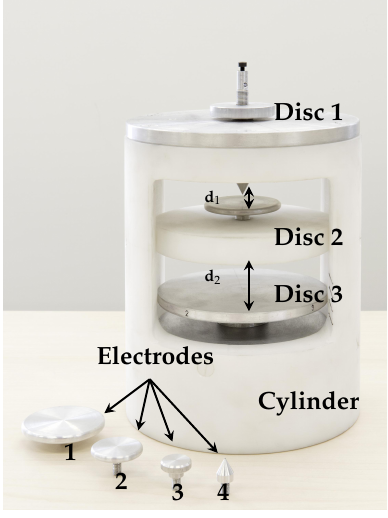
Figure 2. Partial Discharge Generator